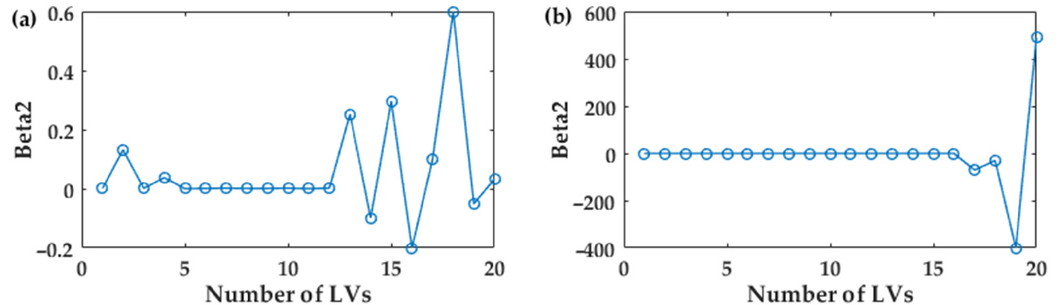
Figure 6. The Beta2 of inputs in the Lasso regression model for ( a ) SSC of apple and ( b ) moisture of marzipan. SSC: soluble solids contents.